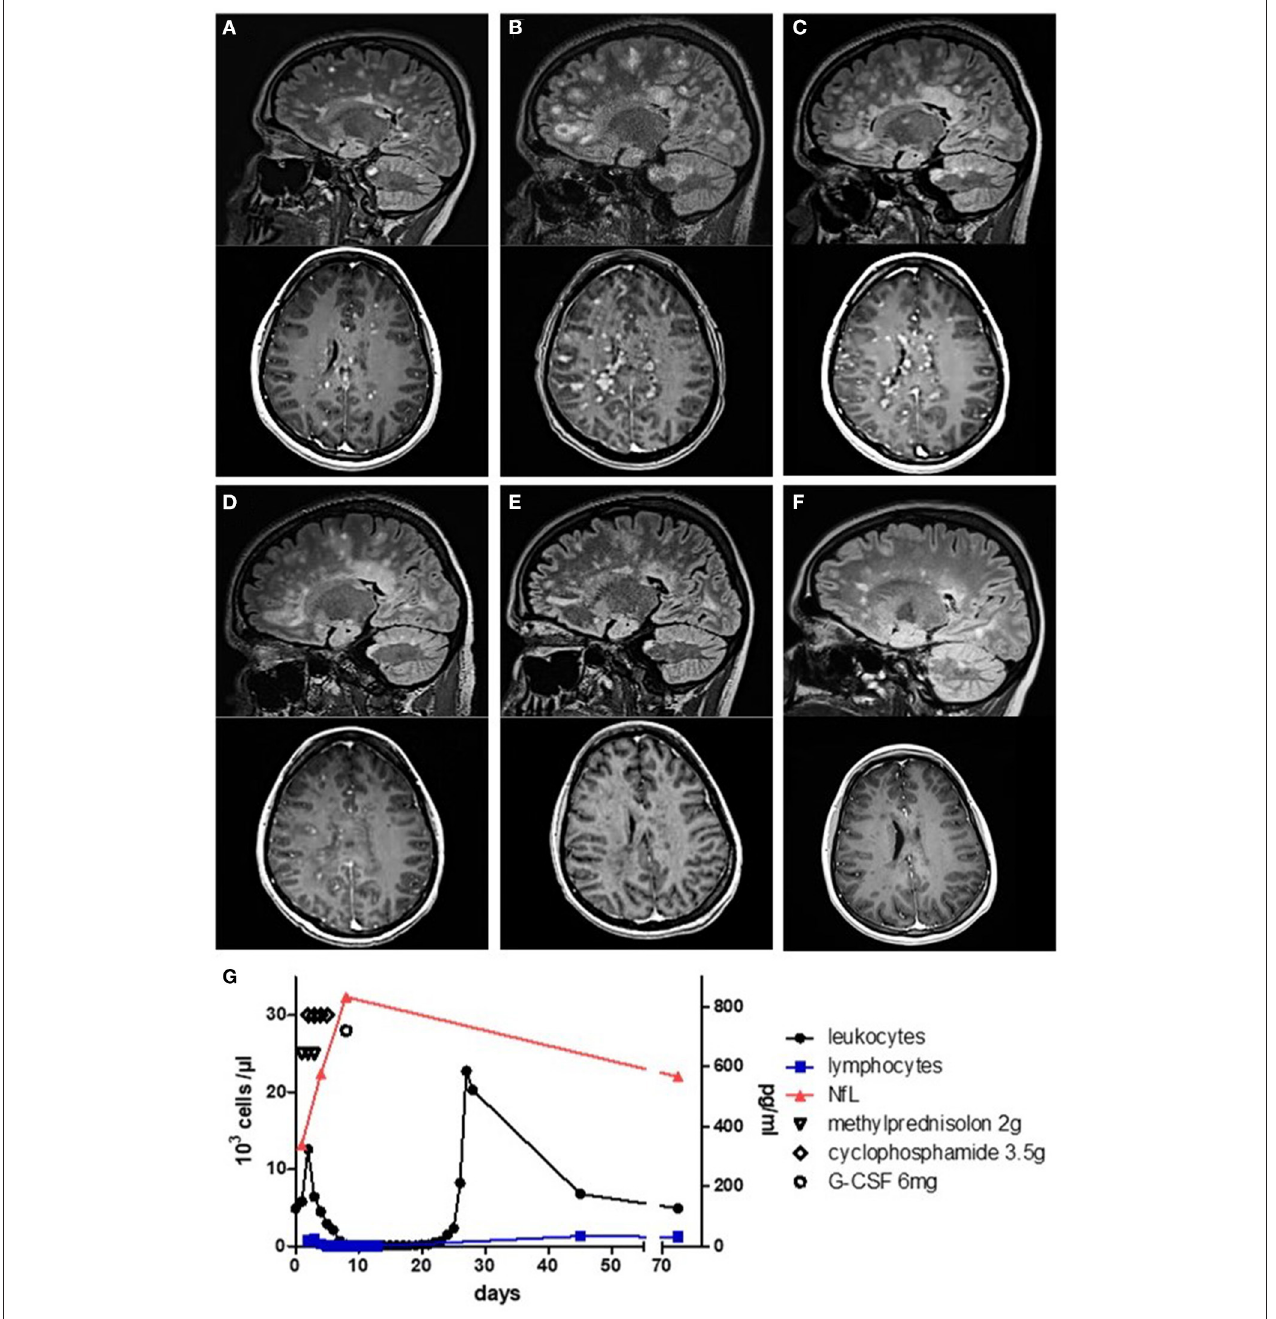
FIGURE 1 | MRI and serological monitoring of the disease course. (A–F) Sagittal FLAIR and axial T1 gadolinium (Gad) sequences. (A) Numerous lesions with Gad enhancement at first admission. (B) MRI at re-admission showing more than 100 Gad-enhancing lesions. (C) Decrease of lesion load 7 days after the first dose of cyclophosphamide. (D) Further decrease of lesion load mirroring clinical remission at 15 days and (E) at 30 days. (F) At 44 days after cyclophosphamide treatment, no more Gad enhancement was detectable. (G) Leukocyte and lymphocyte count as well as serological neurofilament light chain levels during treatment.